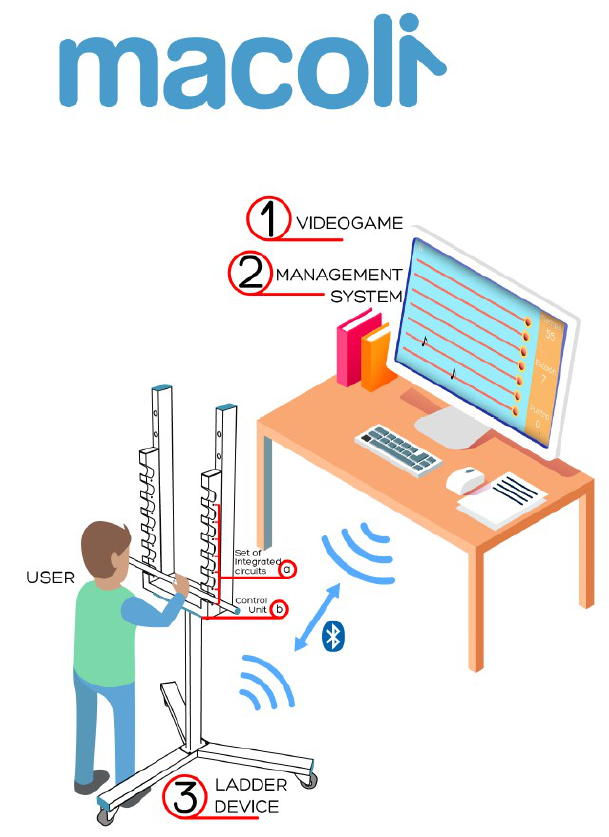
Figure 4. Macoli